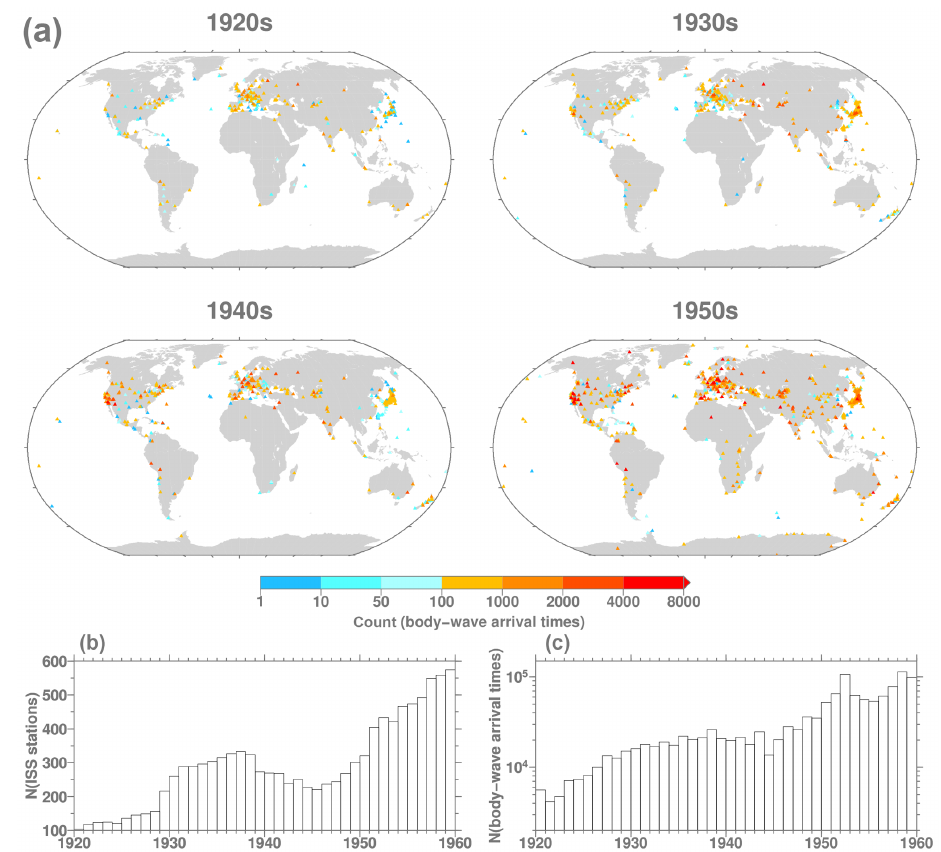
Figure 2. Distribution of stations listed in the ISS in each decade contributing body-wave arrival times to the extension events and colour- coded by number of body-wave arrival times. The annual number of stations (b) and body-wave arrival times (c) are also